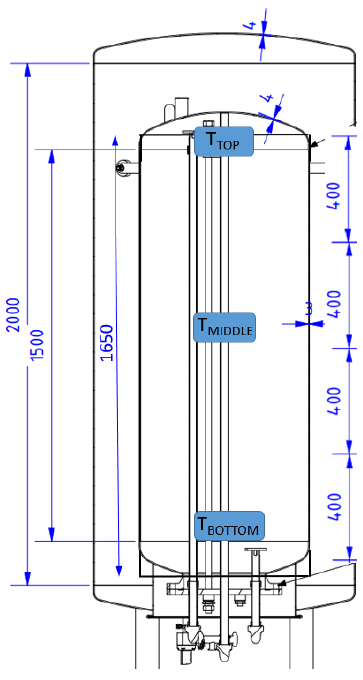
Figure 4. Sketch of the stratified tank [33] used in the simulations.